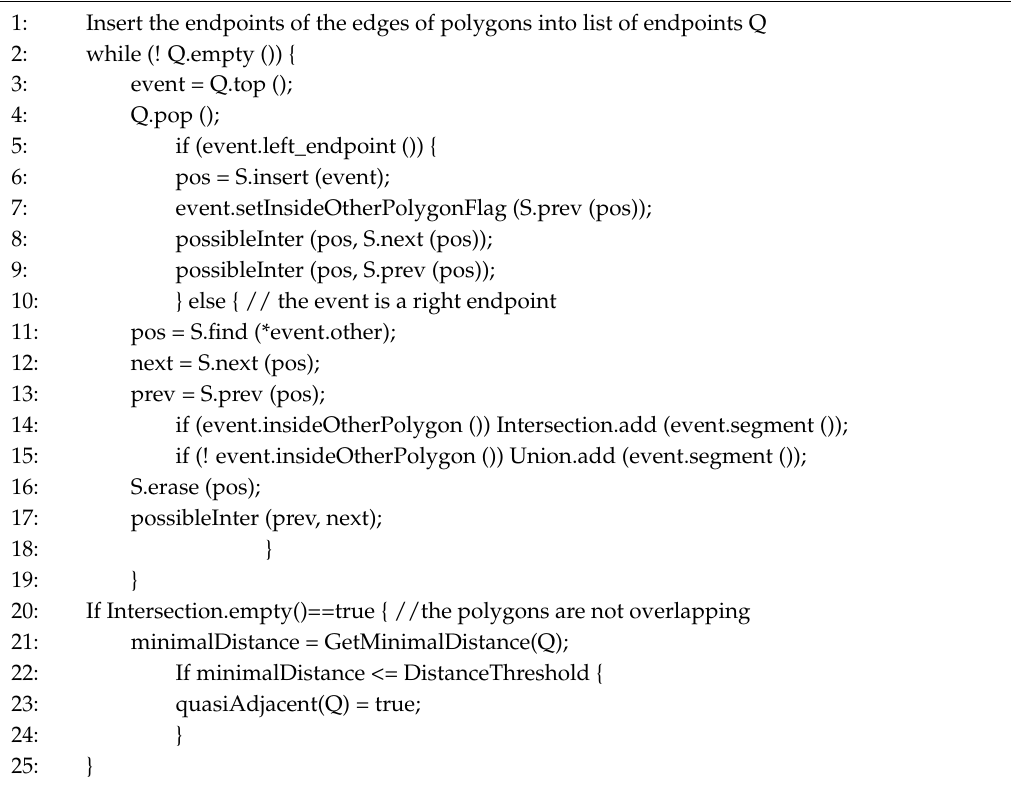
Algorithm 2. Extended Vertical Plane